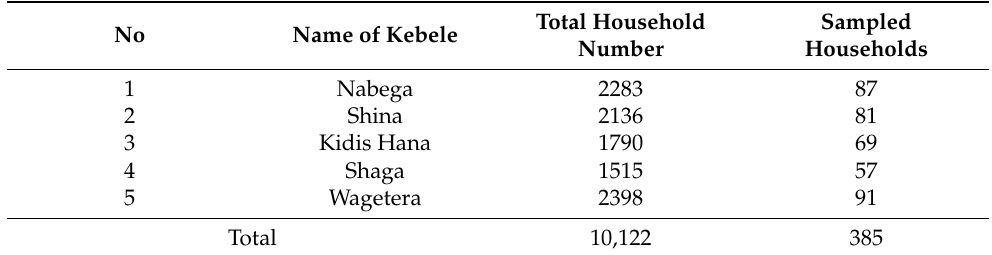
Table 1. Stratified sample population and total household number for sampled kebeles of the Fogera wetlands of South Gondar, Amhara Region, Ethiopia. Total Household Sampled No Name of Kebele Number Households 1 Nabega 2283 87 2 Shina Kidis